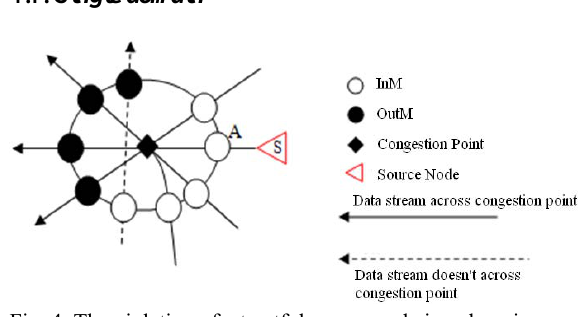
Fig. 4. The violation of a trustful source node in a